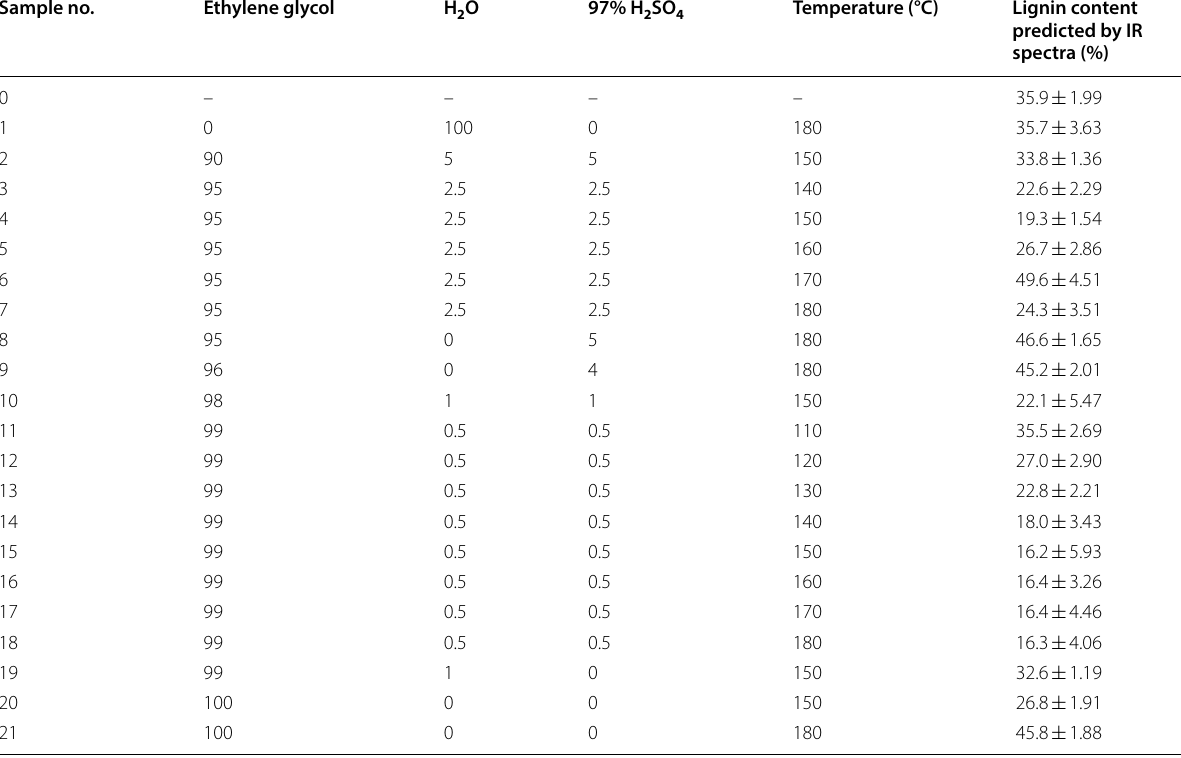
The values on ethylene glycol, H 2 O and 97% H 2 SO 4 indicate a weight ratio in reaction solvent The value on lignin content shows the average and standard deviation calculated from 3 samples